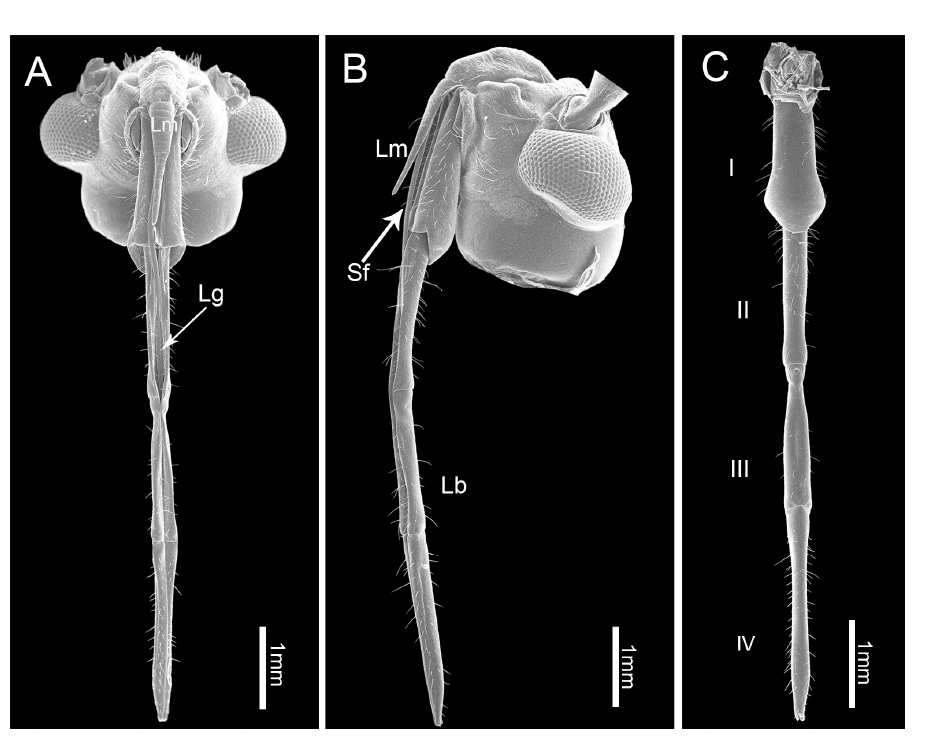
Figure 1. Scanning electron micrographs of the head of adult C. nigrescens . ( A ) Dorsal view; ( B ) lateral view; and ( C ) ventral view showing four-segmented labium (I–IV). Lb, labium; Lg, labial groove; Lm, labrum; and Sf, stylet fascicle.